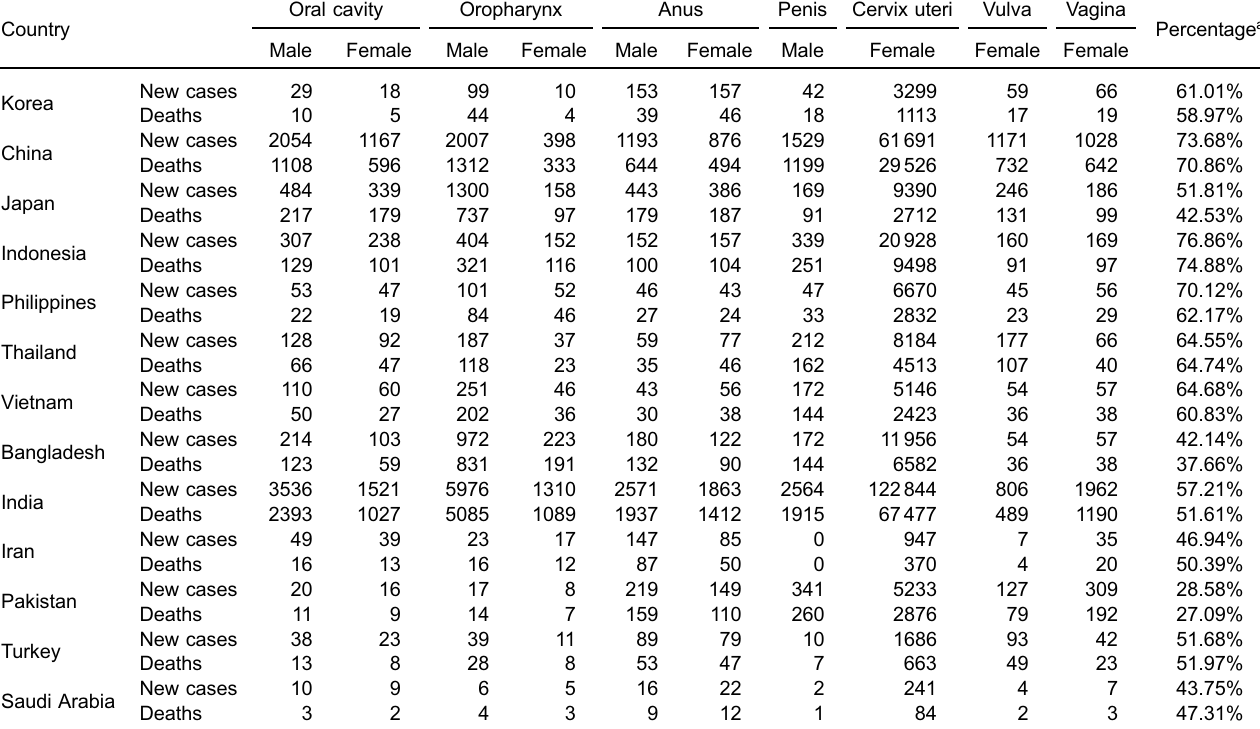
Table 6. Estimated new cancer cases and deaths attributed to HPV in 2012, by